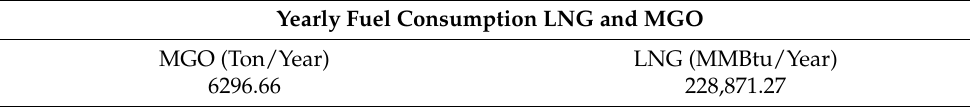
Table 5. Yearly fuel consumption LNG and MGO.